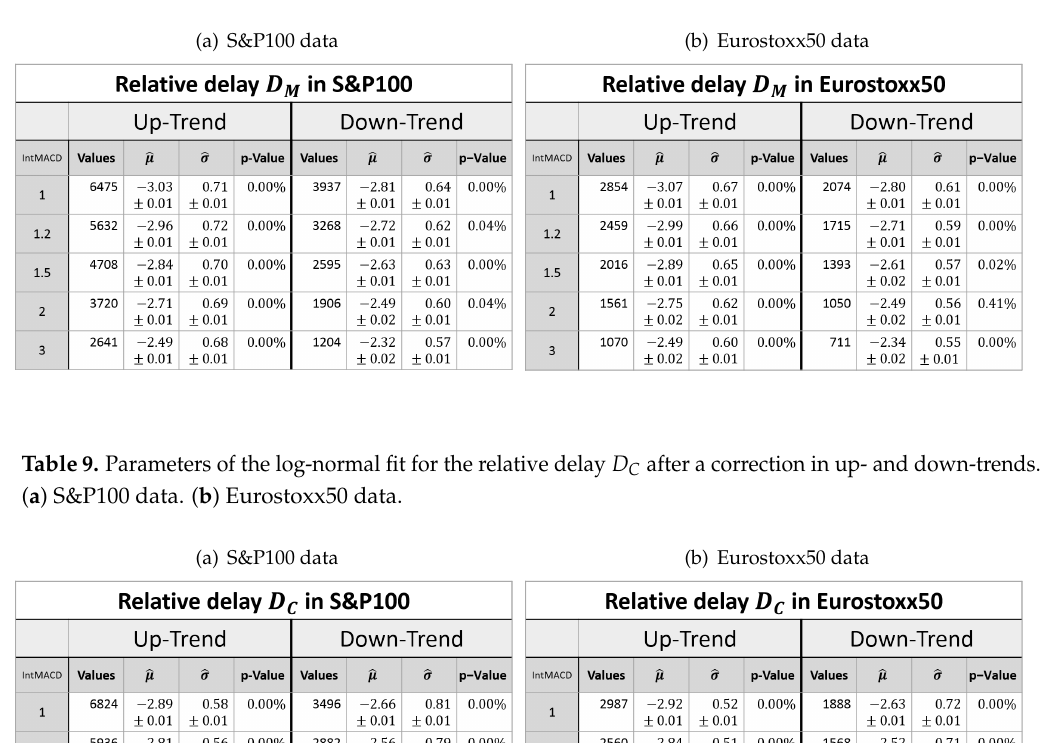
Table 8. Parameters of the log-normal fit for the relative delay D M after a movement in up- and down-trends.